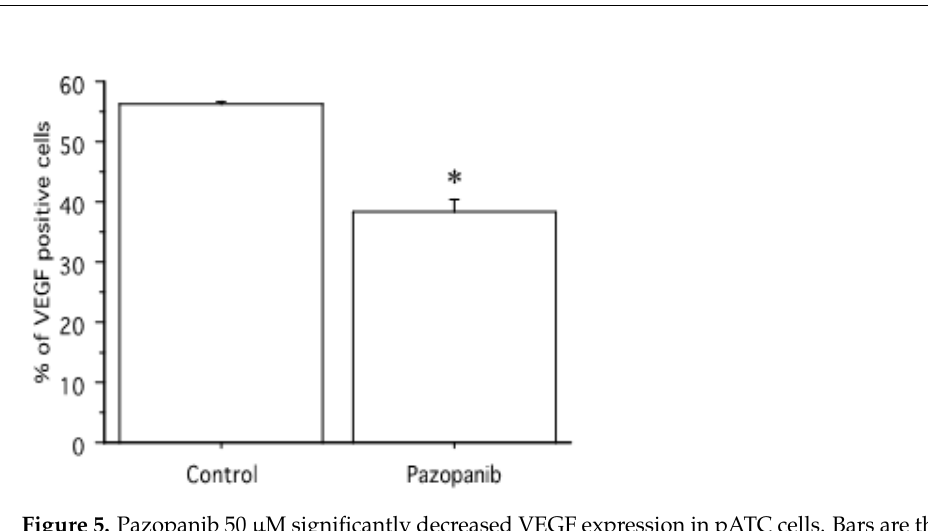
Figure 5. Pazopanib 50 µM significantly decreased VEGF expression in pATC cells. Bars are the mean ± SD. * p < 0.05 vs. control.